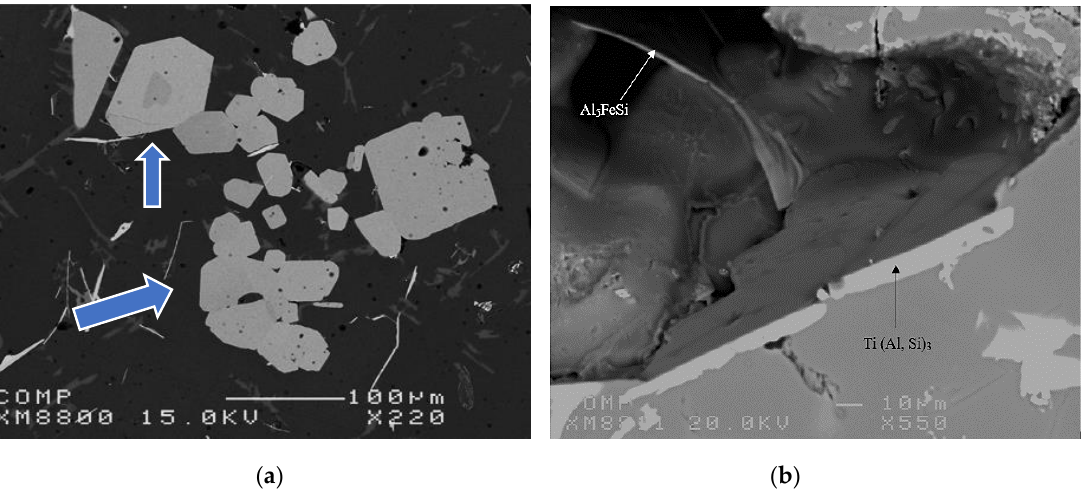
Figure 12. ( a ) Backscattered electron image of (Al,Si) 3 Ti platelets (arrowed blue) in the 0.35%Ti-con- taining A356 alloy and ( b ) a high magnification micrograph of the (Al,Si) 3 Ti platelets.